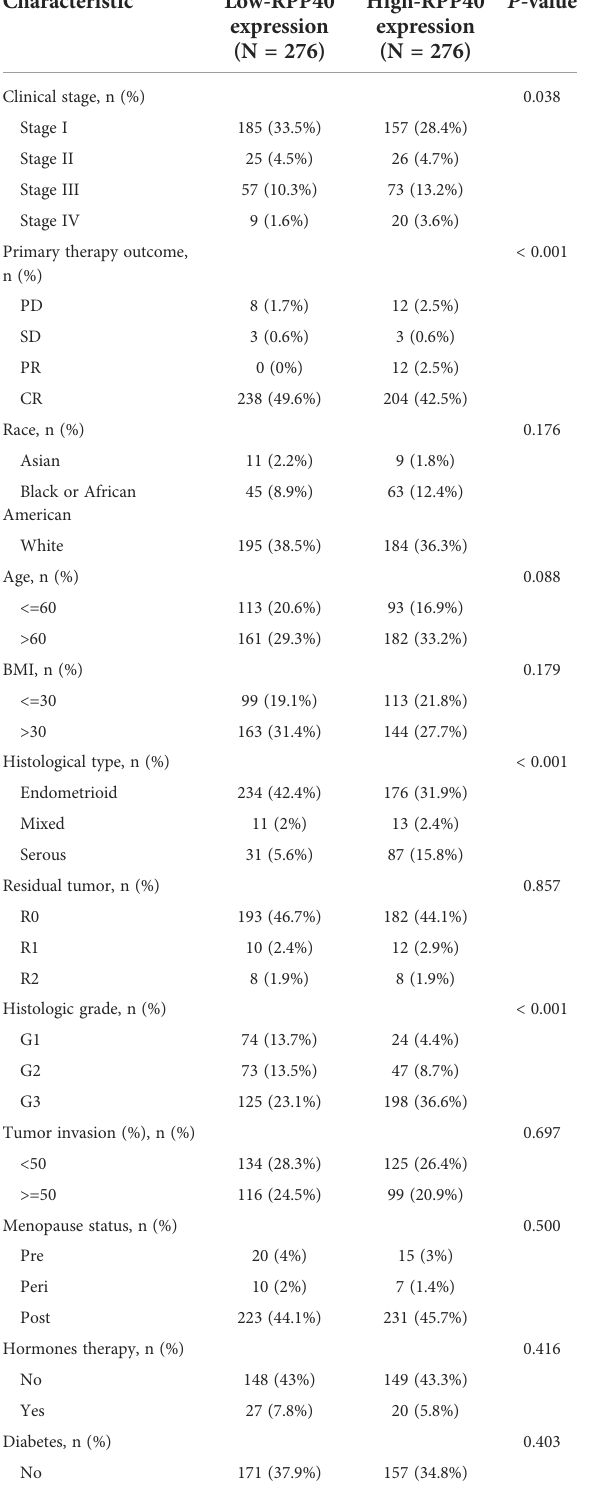
TABLE 1 Clinicopathological characteristics of uterine corpus endometrial carcinoma (UCEC) patients with differential RPP40